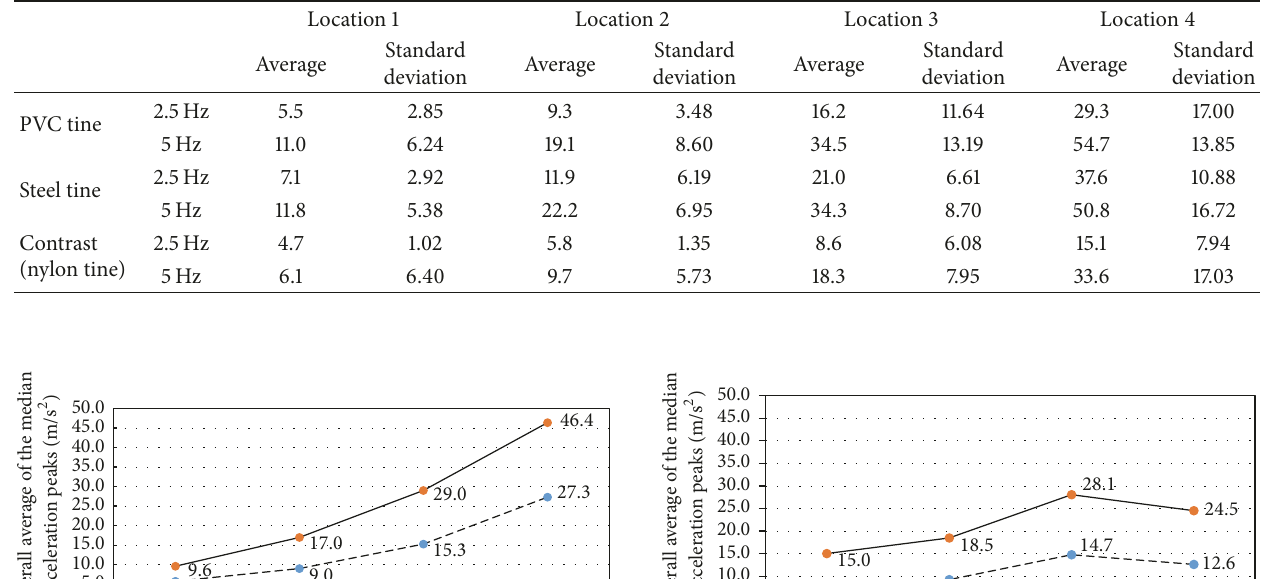
Table 3: The average and standard deviation of the median of the resultant acceleration peaks for trial 1 (m/s 2 ).